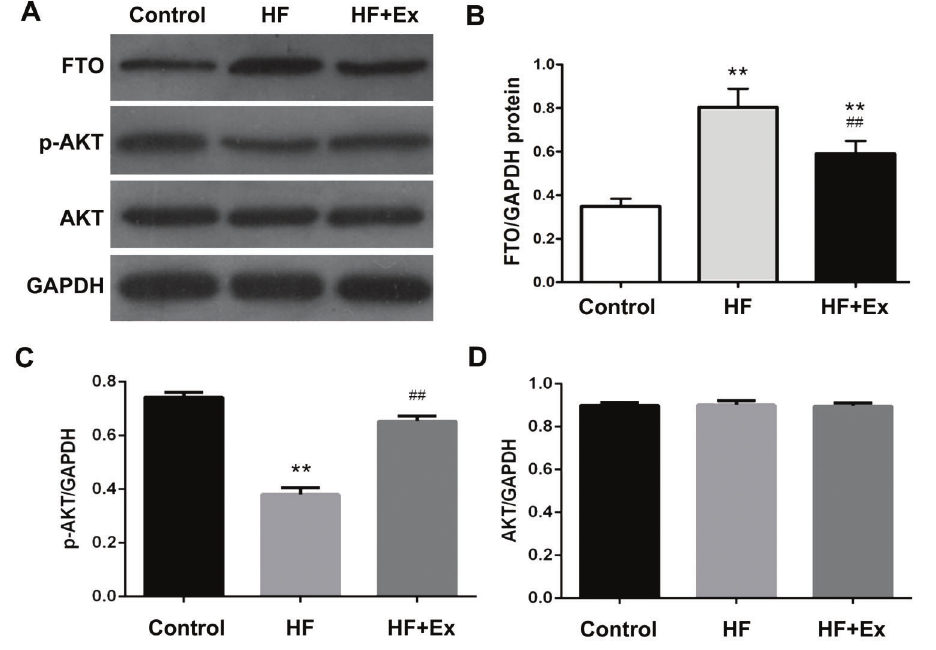
Figure 5. Effect of exenatide (Ex) on high fat (HF)-induced mass and obesity associated gene ( FTO ) expression in rabbit liver tissue (n=8). A and B , FTO protein expression; C and D , pAKTand AKT protein expression. Data were normalized relative to the GAPDH level for each sample and are reported as means ± SD. **P o 0.01 compared with the control group; ## P o 0.01 compared with the HF group (one-way ANOVA and paired t